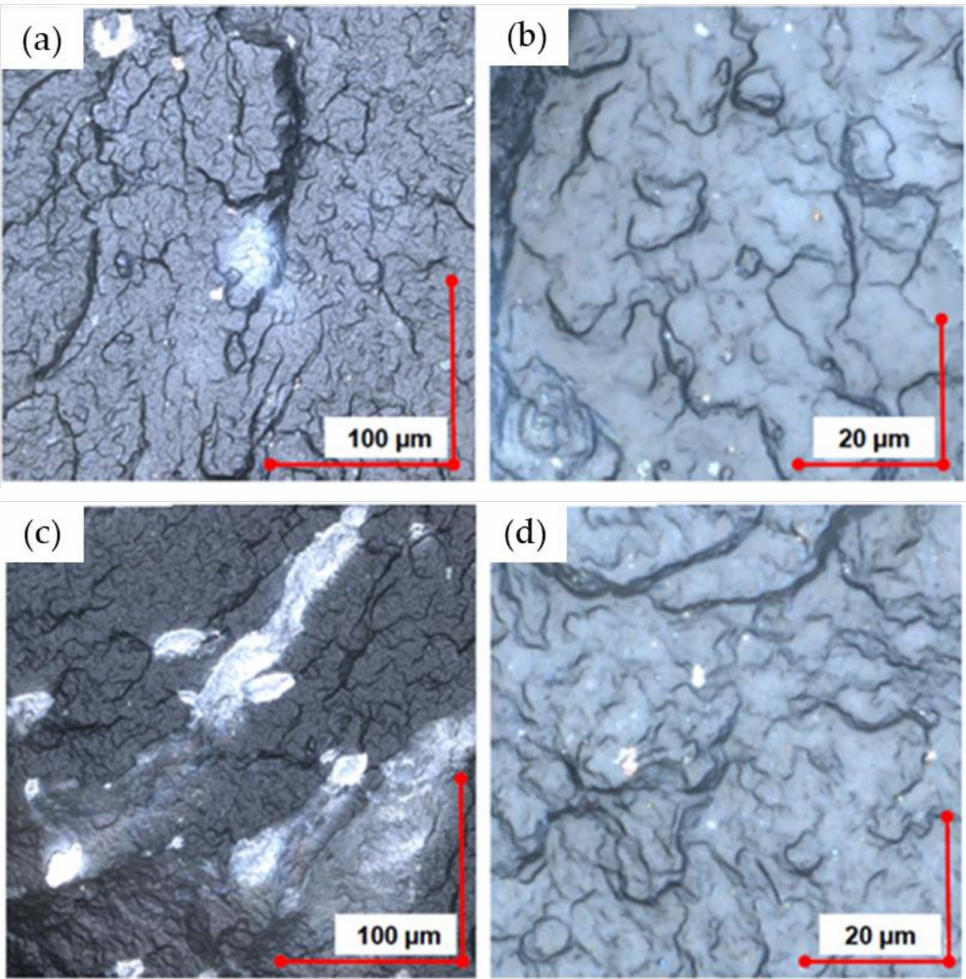
Figure 5. Break section of PP samples (magnification 4284 × ) filled with waste silica: ( a , b ) 3% content; ( c , d ) 10% content.